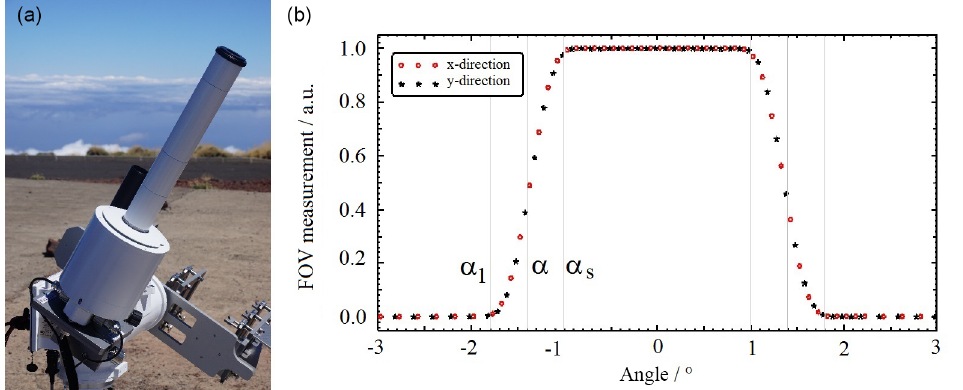
Figure 3. (a) The BTS2048-UV-S-WP modified for direct solar measurements mounted on a solar tracker at the Izaña Atmospheric Obser- vatory in Tenerife. (b) Field-of-view (FOV) measurement in x and y direction for the entrance optics tube according to Blanc et al. (2014). α s = 1 ◦ represents the slope angle, α l = 1 . 8 ◦ the limiting angle and α = 1 . 4 ◦ the half opening angle. The full opening angle results in 2 × α = 2 . 8 ◦